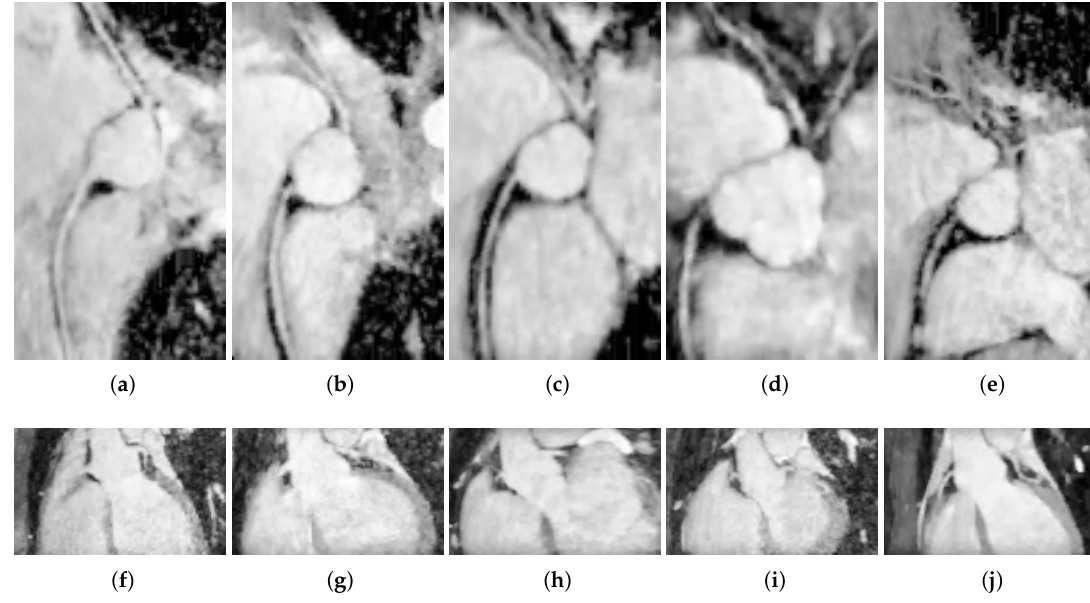
Figure 6. Representative examples of the generated curved ( a – e ) and multiplanar ( f – j ) reformatted